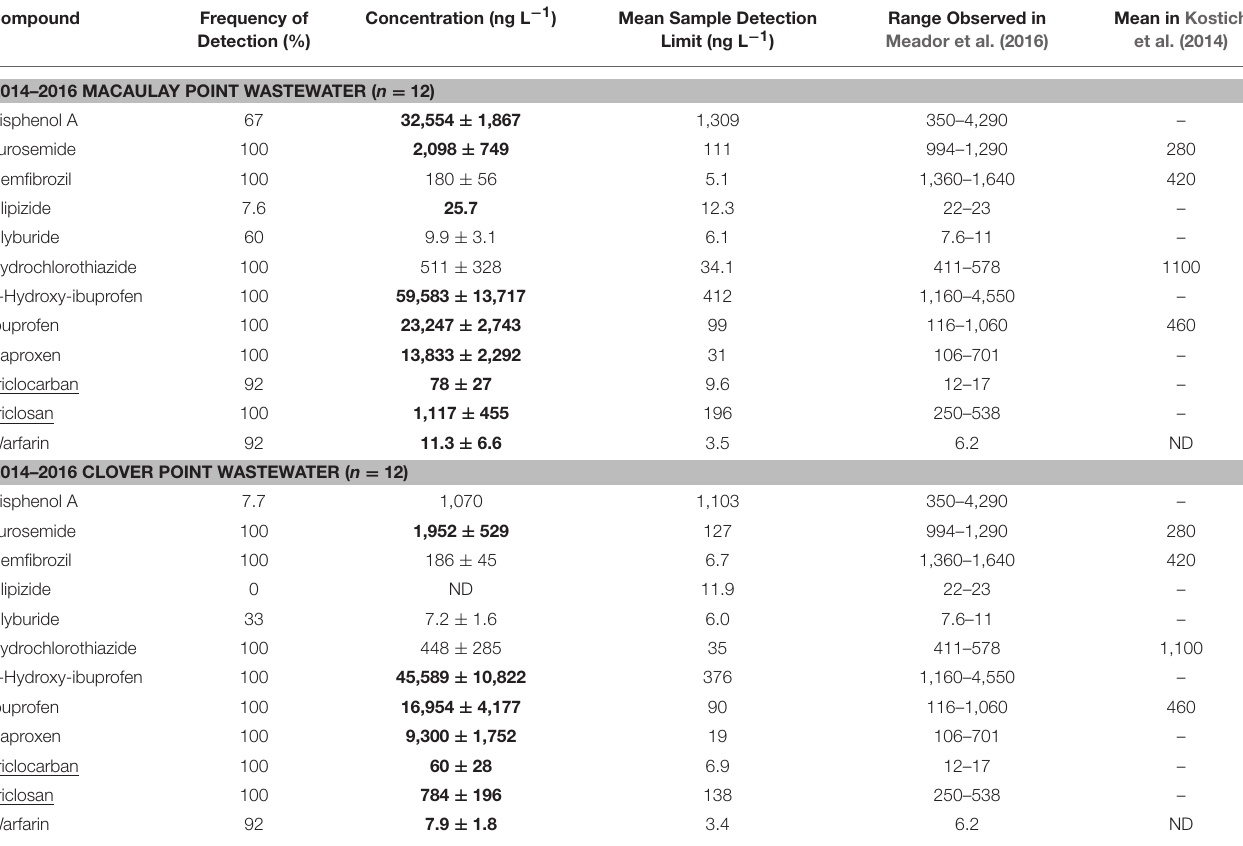
TABLE 2 | Concentrations (mean ± standard deviation) of detected PPCPs in CLO and MAC wastewater observed between 2014 and 2016.